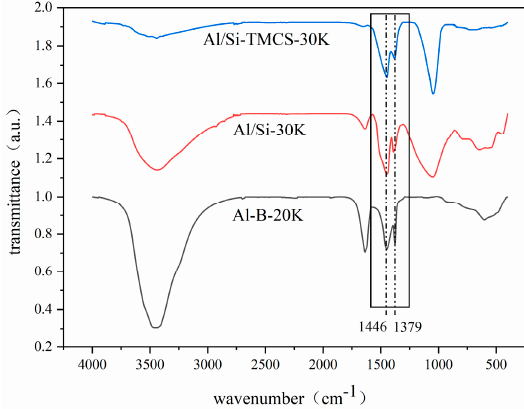
Figure 7. FT-IR spectra of the adsorbents after loading. Materials 2020 , 13 , x FOR PEER REVIEW